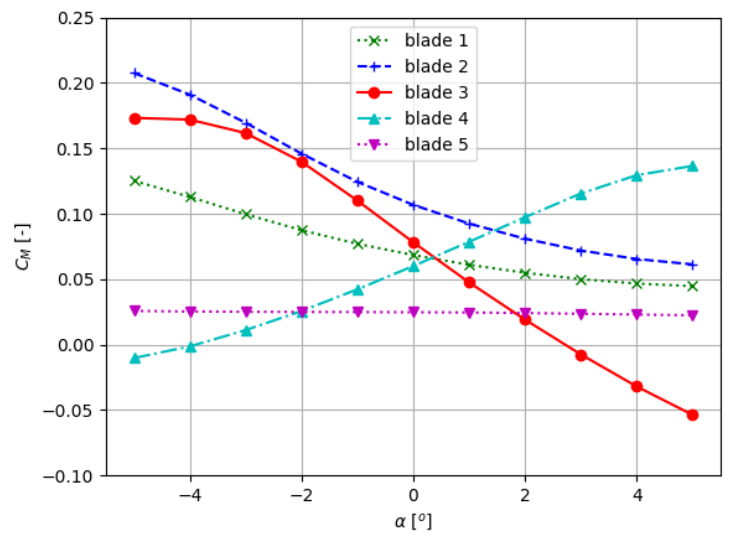
Figure 20. Torsional moment coefficient dependence on middle blade incidence angle offset α